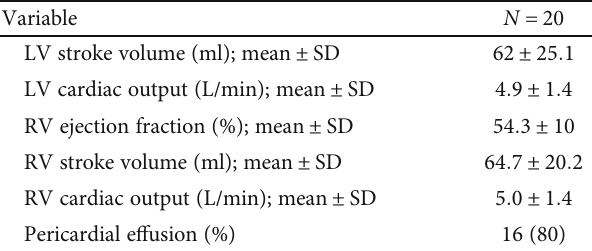
Table 1: Overall baseline clinical